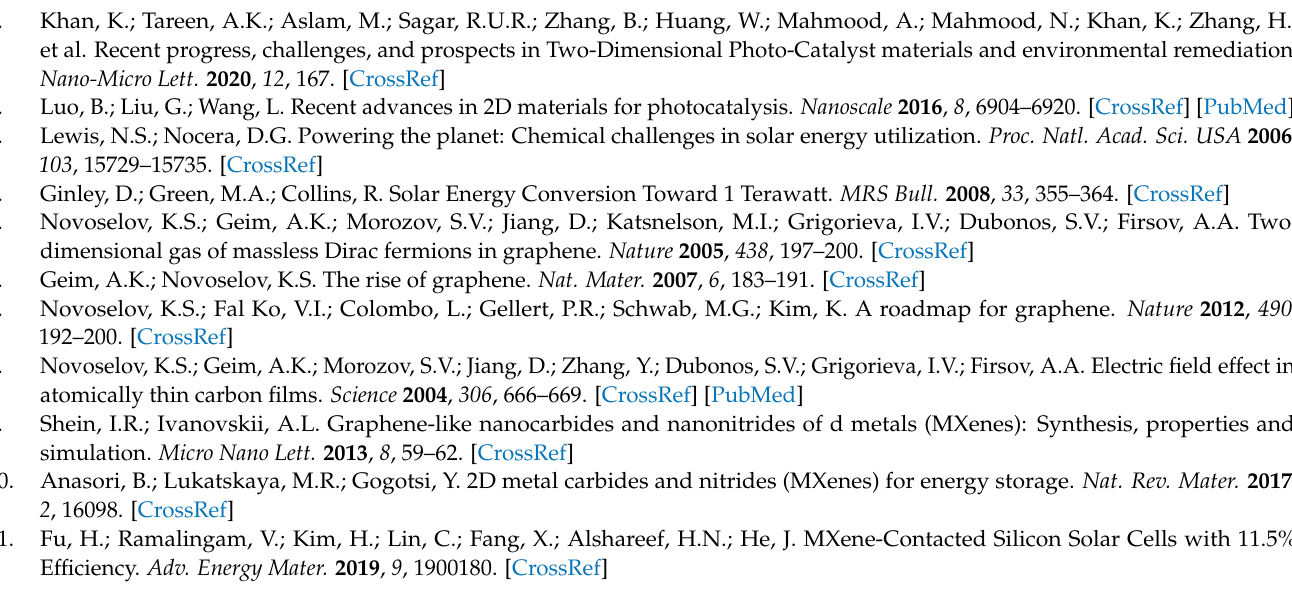
with H as the adsorption atom at (a) A, (b) B, (c) C adsorption site and O as the adsorption atom at (d) A, (e) B, (f) C adsorption site on the Zr 2 CO 2 surface of the Zr 2 CO 2 /MoSe 2 heterostructure; Figure S5. Optimized structures and adsorption energies of the water molecule with H as the ad- sorption atom at (a) D, (b) E, (c) F adsorption site and O as the adsorption atom at (d) D, (e) E, (f) F adsorption site on the Hf 2 CO 2 surface of the Hf 2 CO 2 /MoSe 2 heterostructure; Figure S6. The HSE06 band structures of mutually independent monolayers fixed in the heterostructure lattices for (a) Hf 2 CO 2 /MoS 2 , (b) Hf2CO 2 /MoSe 2 , (c) Hf 2 CO 2 /MoTe 2 , (d) Zr 2 CO 2 /MoS 2 , (e) Zr 2 CO 2 /MoSe 2 and (f) Zr 2 CO 2 /MoTe 2 ; Table S1. The lattice constants a (Å), band gaps E g (eV) and band gap types of M 2 CO 2 (M = Zr, Hf) and MoX 2 (X = S, Se, Te) monolayers; Table S2. The total energy (eV) of different stacking configurations for M 2 CO 2 /MoX 2 heterostructures; Table S3. The lattice constants a (Å), interlayer distance d (Å), degree of lattice mismatch K , formation energy E f (meV) and binding energy E b (meV/Å 2 ) for the most stable configurations of M 2 CO 2 /MoX 2 heterostructures; Table S4. The calculated band gap E g (eV) of the most stable configurations for M 2 CO 2 /MoX 2 heterostructures; Table S5. The total charge transfer amounts between MoX 2 and M 2 CO 2 in the M 2 CO 2 /MoX 2 heterostructures; Table S6. The conduction band offset ∆ E c (eV), donor band gap E d g (eV), and calculated power conversion efficiency (PCE) η (%) of M 2 CO 2 /MoX 2 heterostructures for solar cell applications. References [56–63] are cited in the supplementary